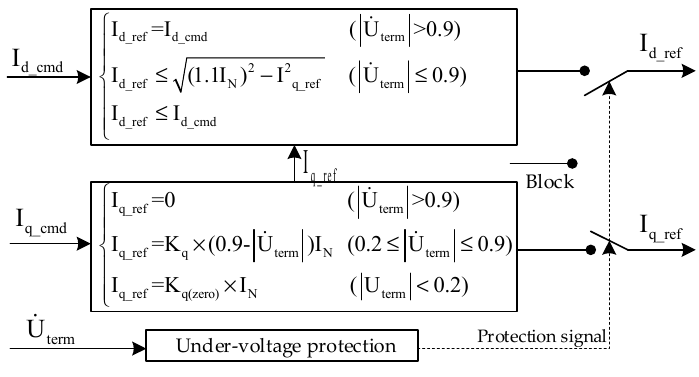
Figure 3. LVRT control.